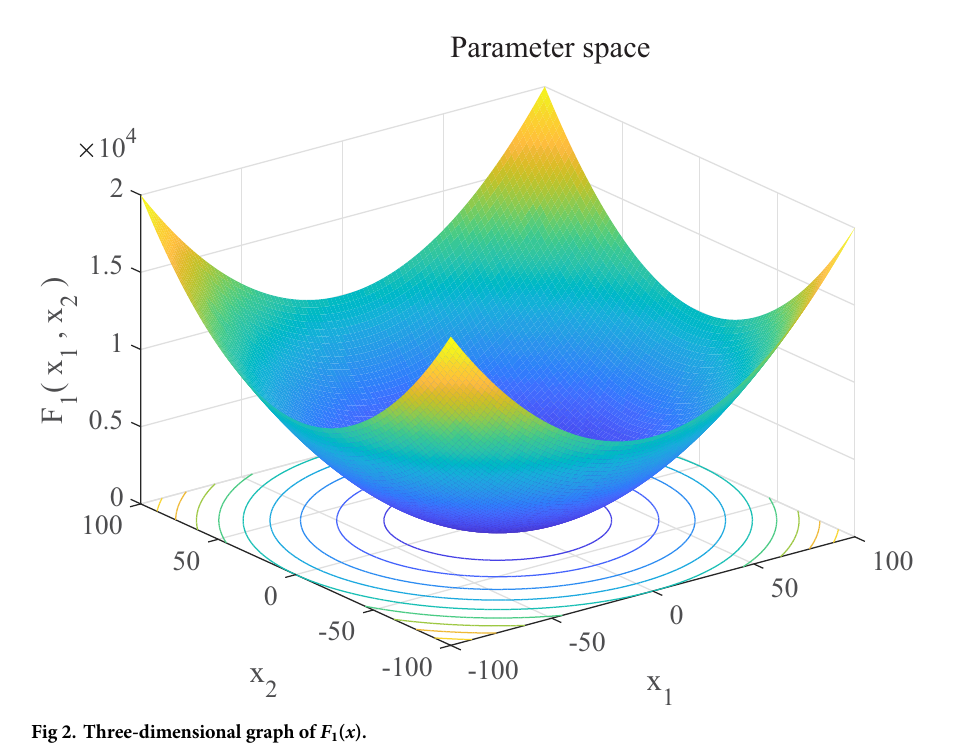
Fig 2. Three-dimensional graph of F 1 ( x